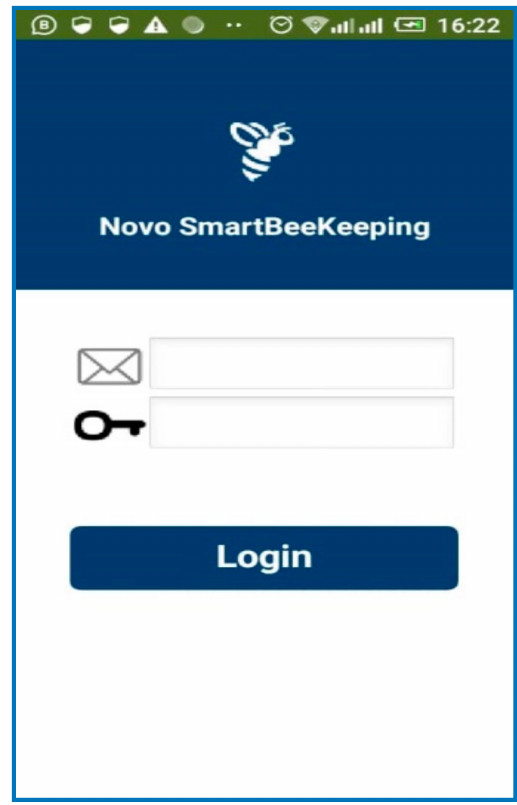
Figure 16. Mobil application user interface for